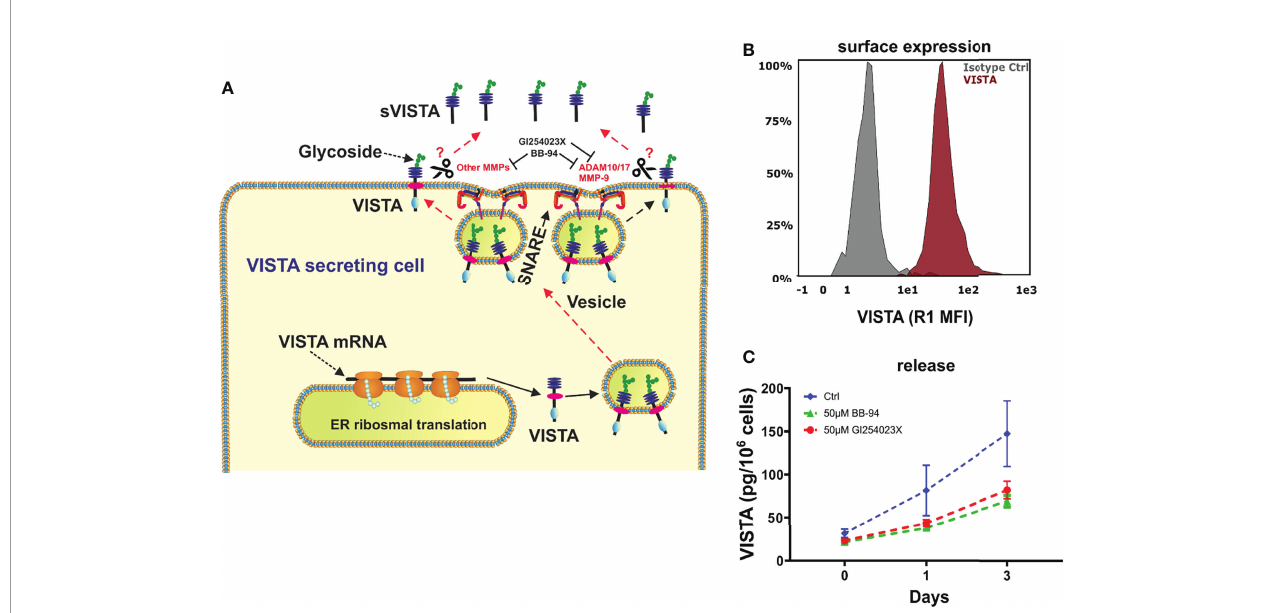
FIGURE 1 | VISTA expression in human monocytes. (A) Scheme showing the surface expression of VISTA and proteases involved in shedding and also demonstrating the action of inhibitors. (B) Monocytes express VISTA on the Surface (histogram of VISTA expression on monocytes) and (C) release soluble VISTA via protease cleavage. VISTA release mediated by cleavage is reduced in the presence of matrix metalloproteinase inhibitors. Data are the mean values ± SEM